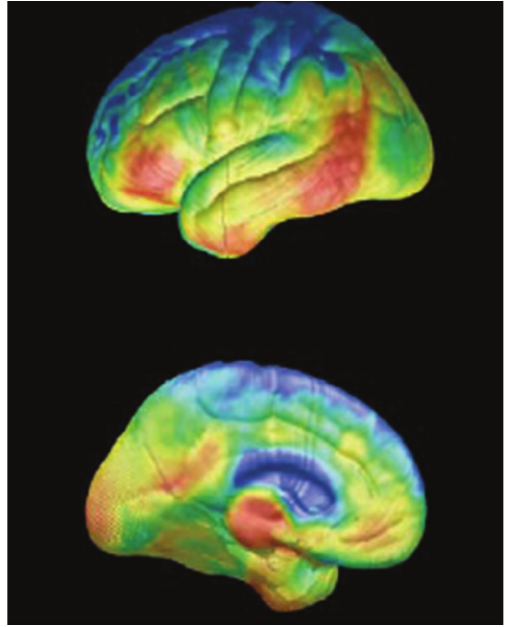
Figure 3: Three-dimensional cortical surface projection images of [F-18]FDDNP-PET scans from a patient with AD. Lateral (upper) and medial (lower) brain surfaces are shown. Warmer colors indicate higher numbers of plaques and tangles. Adapted and reprinted with permission from Small et al. [16] [Copyright (2008) Lancet Neurology].